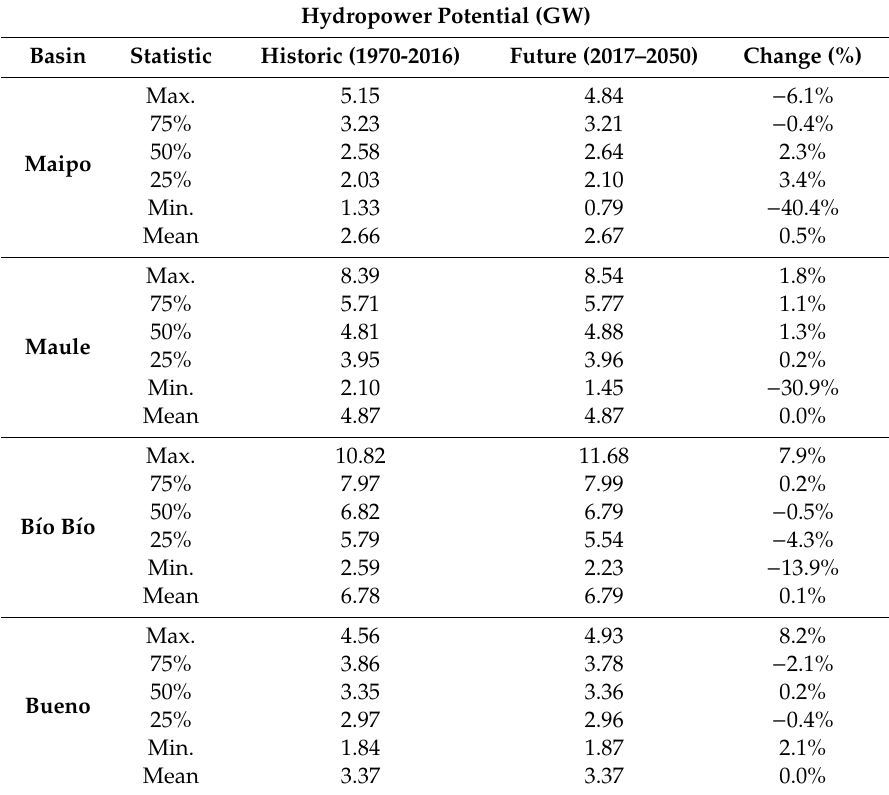
Table 3. Average projected change in hydropower potential in the four study basins.